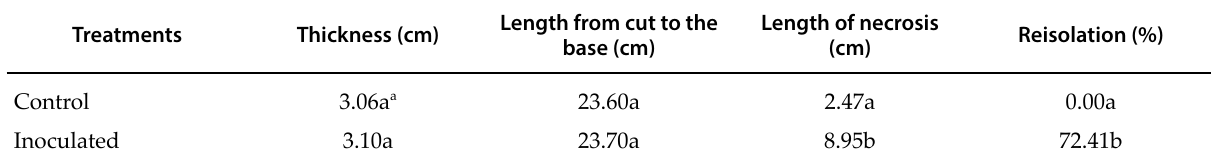
Table 6. Results of pathogenicity experiment carried out in a vineyard of cv. Touriga Nacional.